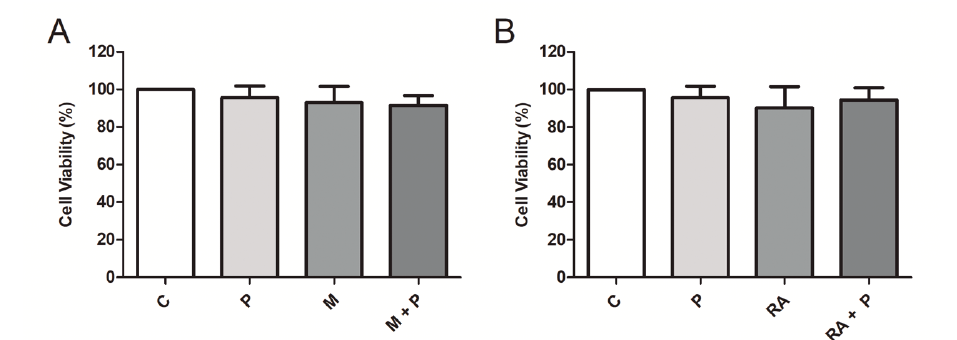
Figure 2. Viability (%) of dendritic cells (1 × 10 6 cells/mL) after 48 h incubation with RPMI 1640 (control – C), propolis (P – 5 μg/mL), (A) MAGE-1 (M – 10 μg/mL), (B) retinoic acid (RA – 10 -7 M) and their combination. Data represent mean and standard deviation of five subjects ( p >